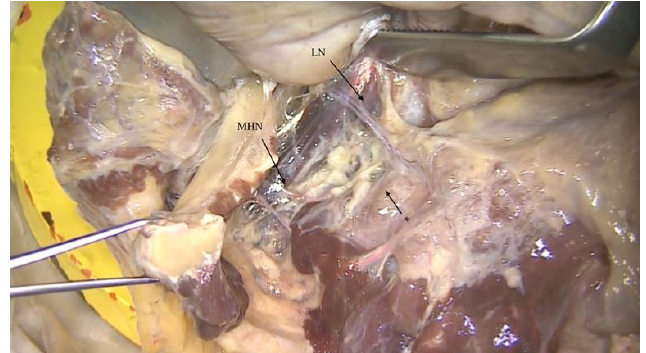
Figure 2. Anatomical pictures of a human body dissection showing both the nerve to the mylohy- oid (MHN) and the lingual nerve (LN). The anastomosis between nerve to the mylohyoid and lingual nerve (*) can be observed.